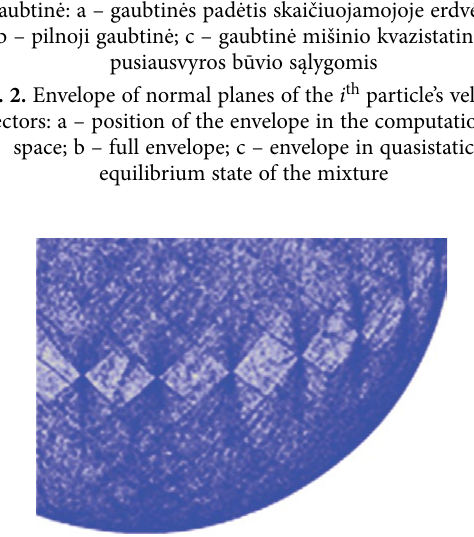
gaubtinė: a – gaubtinės padėtis skaičiuojamojoje erdvėje;